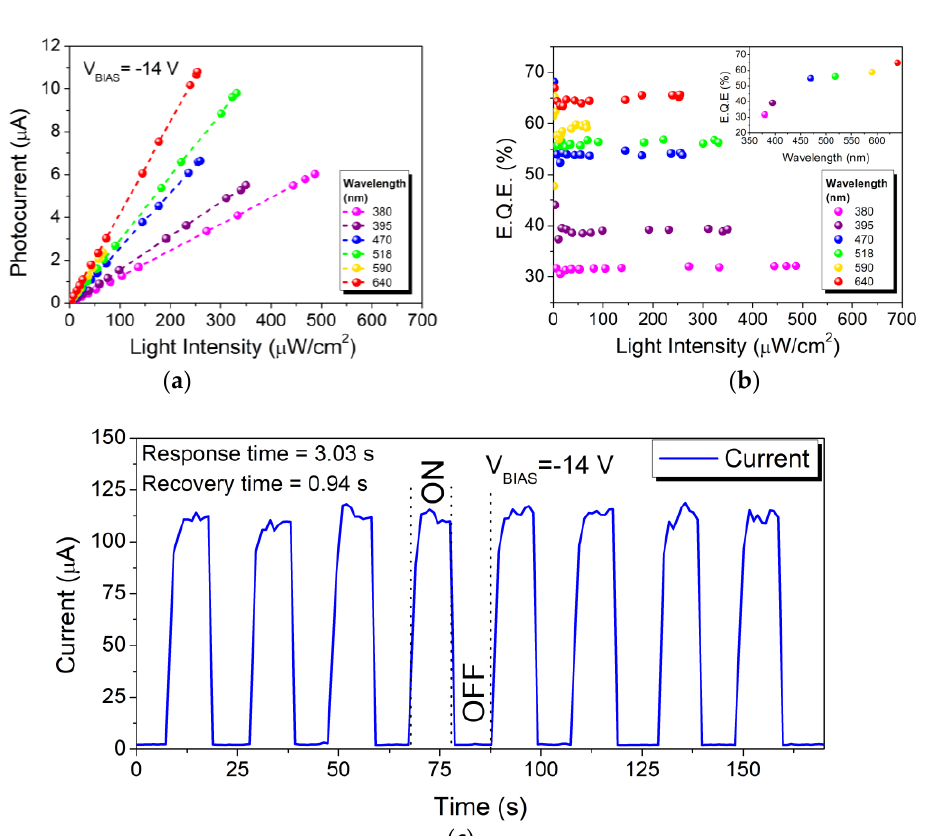
Figure 6. ( a ) Photocurrent vs. light intensity in reverse bias (V = − 14 V) for different wavelengths. ( b ) Calculated E.Q.E. as a function of the light intensity for different wavelengths and (inset) average external quantum efficiency, E.Q.E. , as a function of the wavelength. ( c ) Device current under switching white light (wavelength in the range 450 nm to 2400 nm and intensity 2 W/cm 2 ).